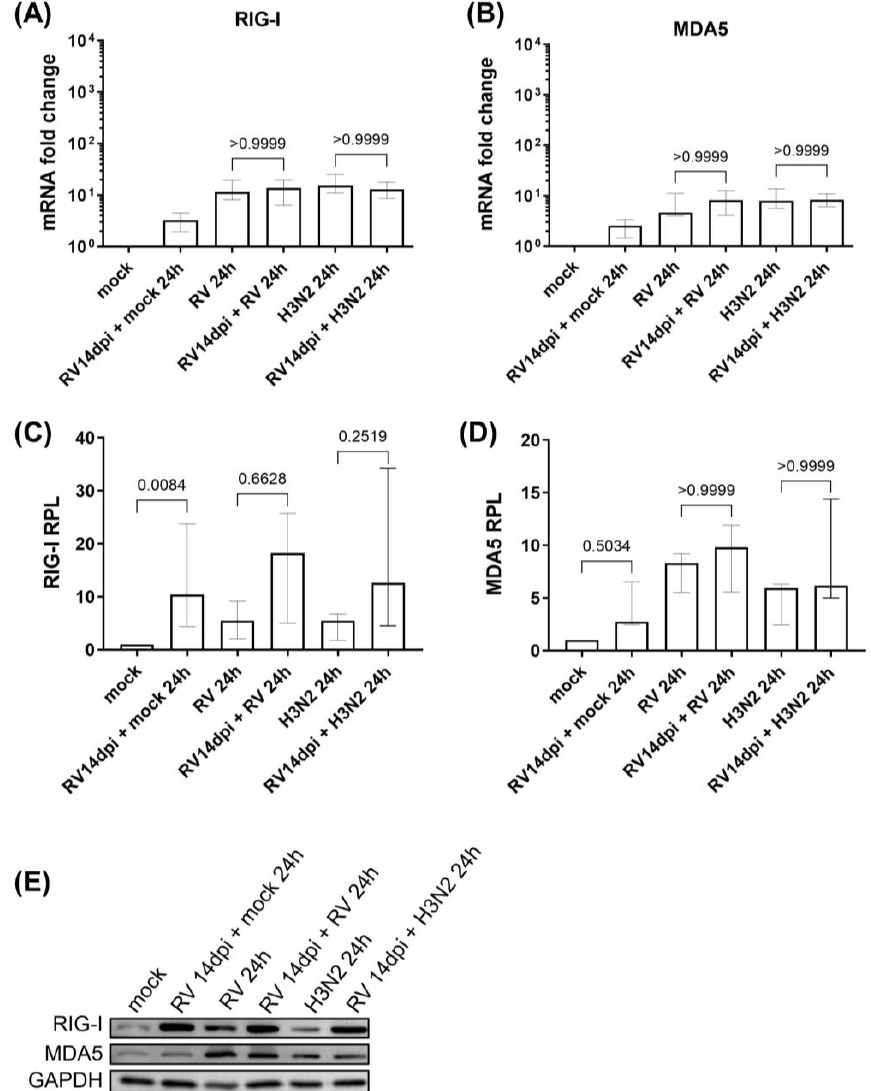
Figure 2. Increased protein expression of RIG-I, but not MDA5, during secondary H3N2 infection and HRV-A16 re-infection of hNECs (following primary prolonged HRV infection). The mRNA expression profiles of ( A ) RIG-I and ( B ) MDA5 in infected and mock control hNECs ( n = 6). Relative protein levels (RPL) of ( C ) RIG-I and ( D ) MDA5 in infected and mock control hNECs ( n = 5). The relevant band intensities were measured using ImageJ software. Protein levels were normalized to GAPDH housekeeping protein. ( E ) Representative Western blot images are depicted. The p -value was calculated by one-way ANOVA and non-parametric Kruskal–Wallis test. The data are represented as medians with interquartile values.